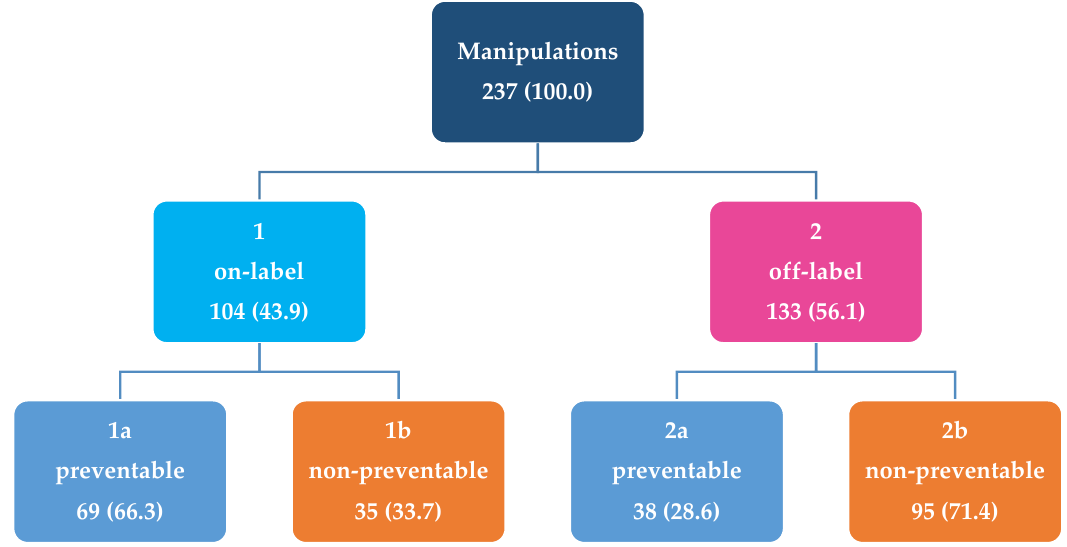
Figure 1. Flowchart of manipulations (n (%)) classified by licensing status (on ‐ and off ‐ label) and preventability (preventable and non ‐ preventable).